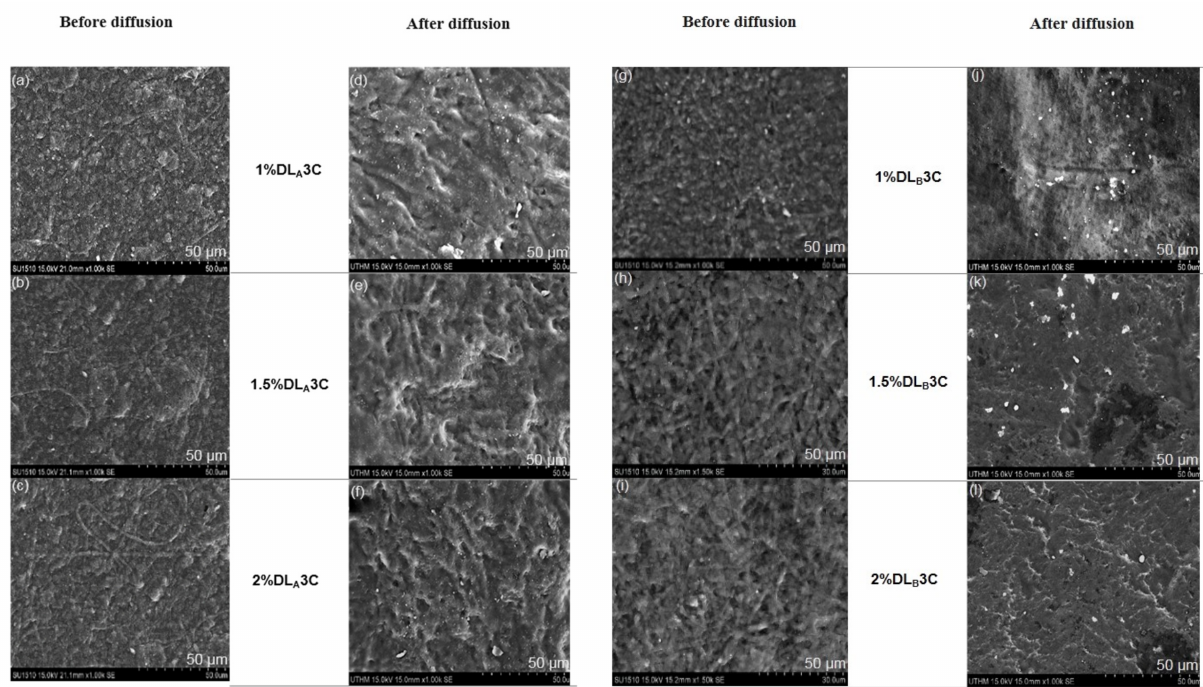
Figure 6. Morphological structures of the dual layer PVA patches (nanofiber side) before and after diffusion process: ( a − f ) DS-medicated DL A 3C and ( g − l ) DS-medicated DL B